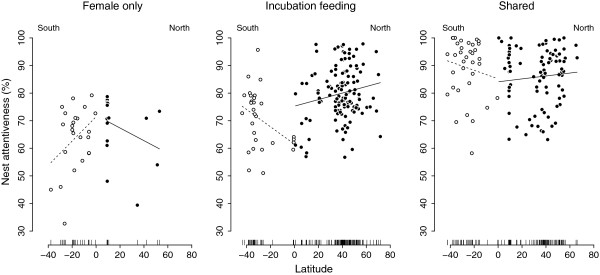
Total nest attentiveness in relation to latitude (degrees S or N) separately for the three incubation strategies and the two hemispheres (overall N = 320). Points are species averages and fitted lines are ordinary linear regressions for illustrative purposes only.